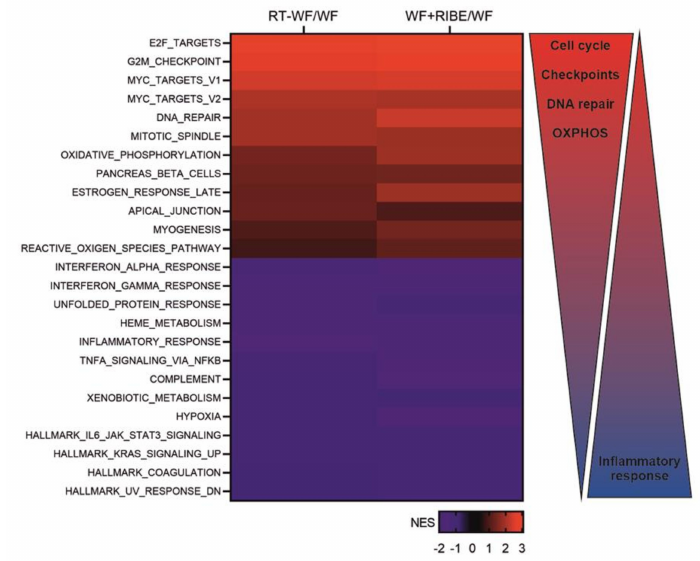
Figure 2. Biological processes enriched in RT-WF and WF + RIBE-treated cells are similar. MDA-MB-468 cell lines were incubated with WF, RT-WF, and WF + RIBE fluids for two days and subjected to microarray analysis. The fluids were compared to controls to identify di ff erentially expressed